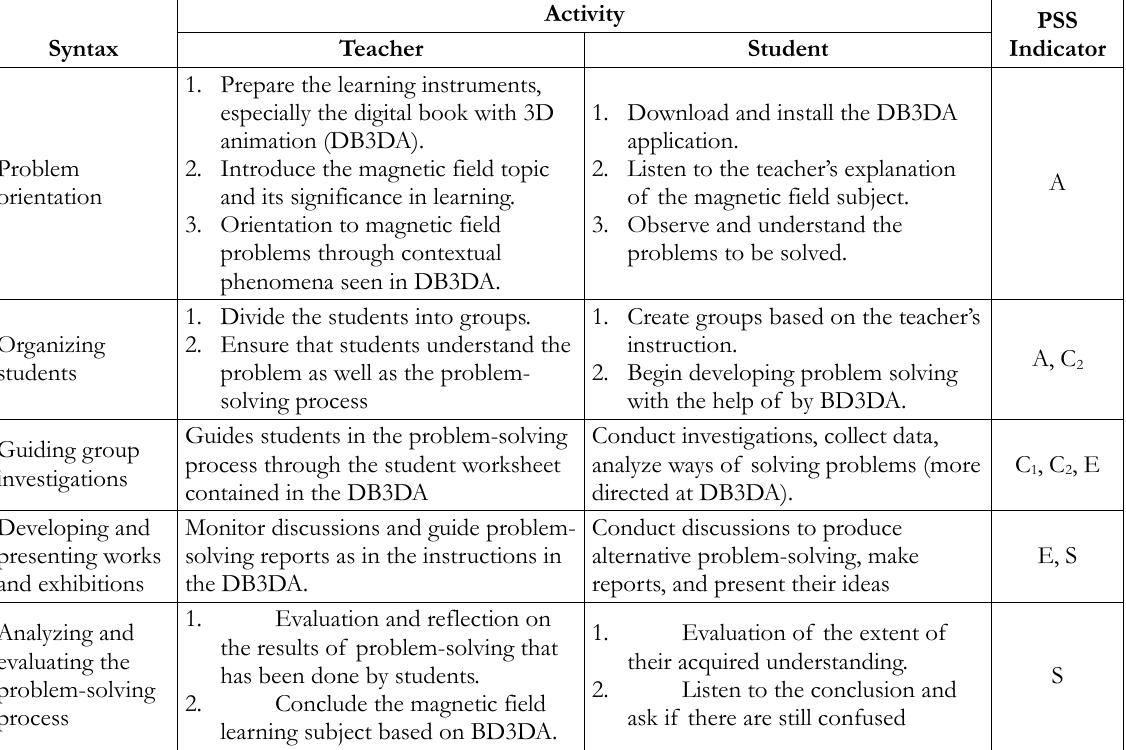
Table 2. Learning activities in the experimental class (Arends,